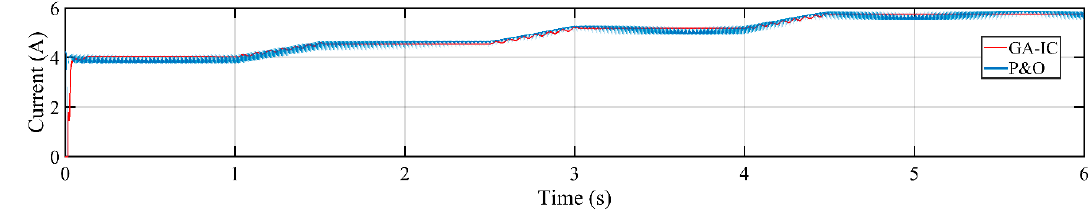
Figure 28. Case 2 current, detailed comparison of modified GA-IC vs. P&O.